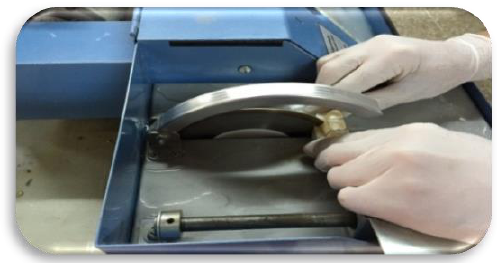
Figure 4: sectioning machine with water